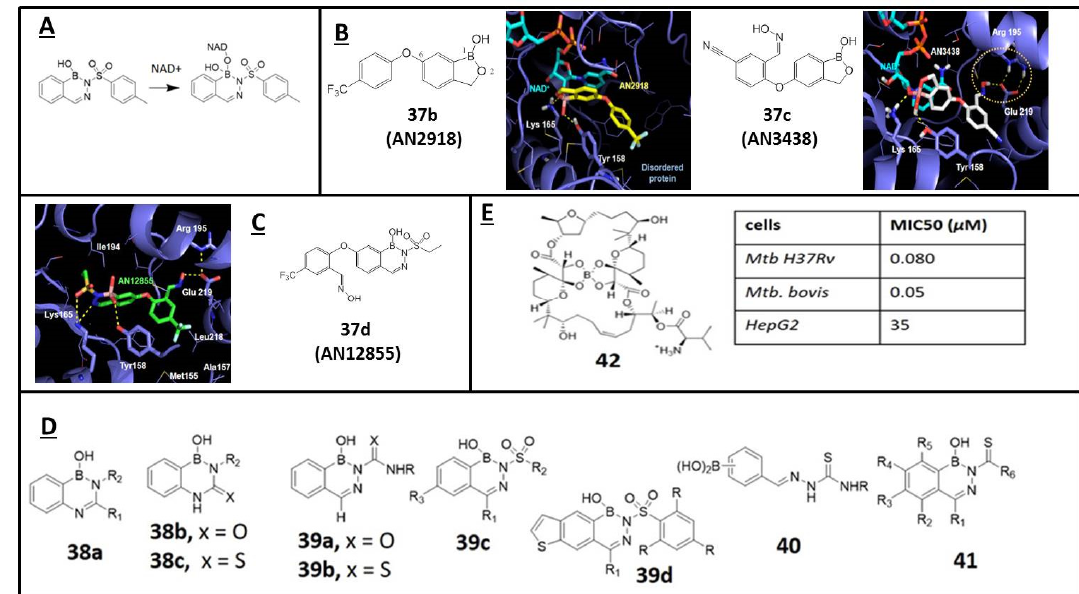
Figure 5. A Formation of a covalent B–O bond of diazaborines with the OH group at C (2 ′ ) of the NAD cofactors ribose unit of enzyme ENR; B Structure of oxaborole 37b (AN2918) and 37c (AN3418) and their complex crystal structure with Mtb InhA; C Structure of diazoborine 37d (AN12855) and its complex crystal structure with Mtb InhA; D Structures and antifungal activity of 2,3,1-benzodiazaborines 38 – 41 ; E Structures and cytotoxicity activities of Boromycin 42 (Adapted from [68,70–73]).